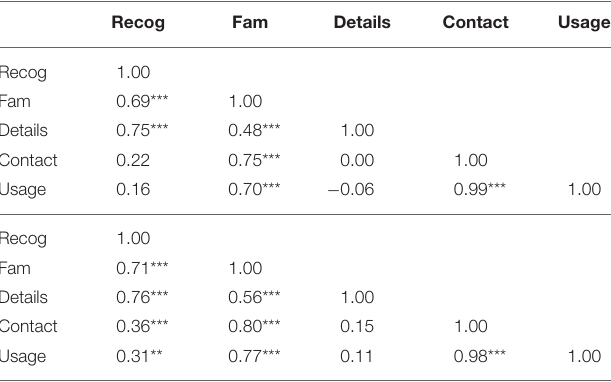
TABLE 2 | Correlation matrix for the younger (upper panel) and older (lower panel) adults. Recog Fam